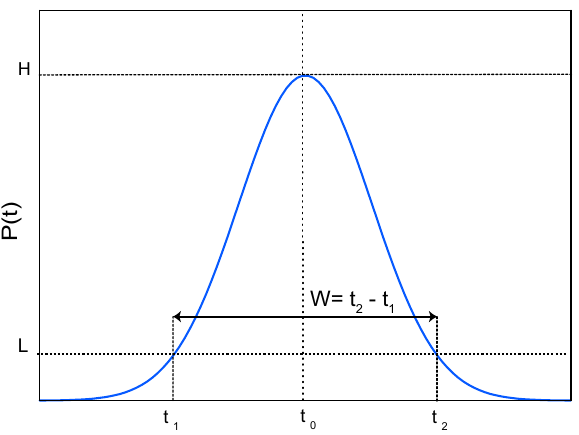
Fig. 6. Waveform of an ideal signal pulse. Parameter described in